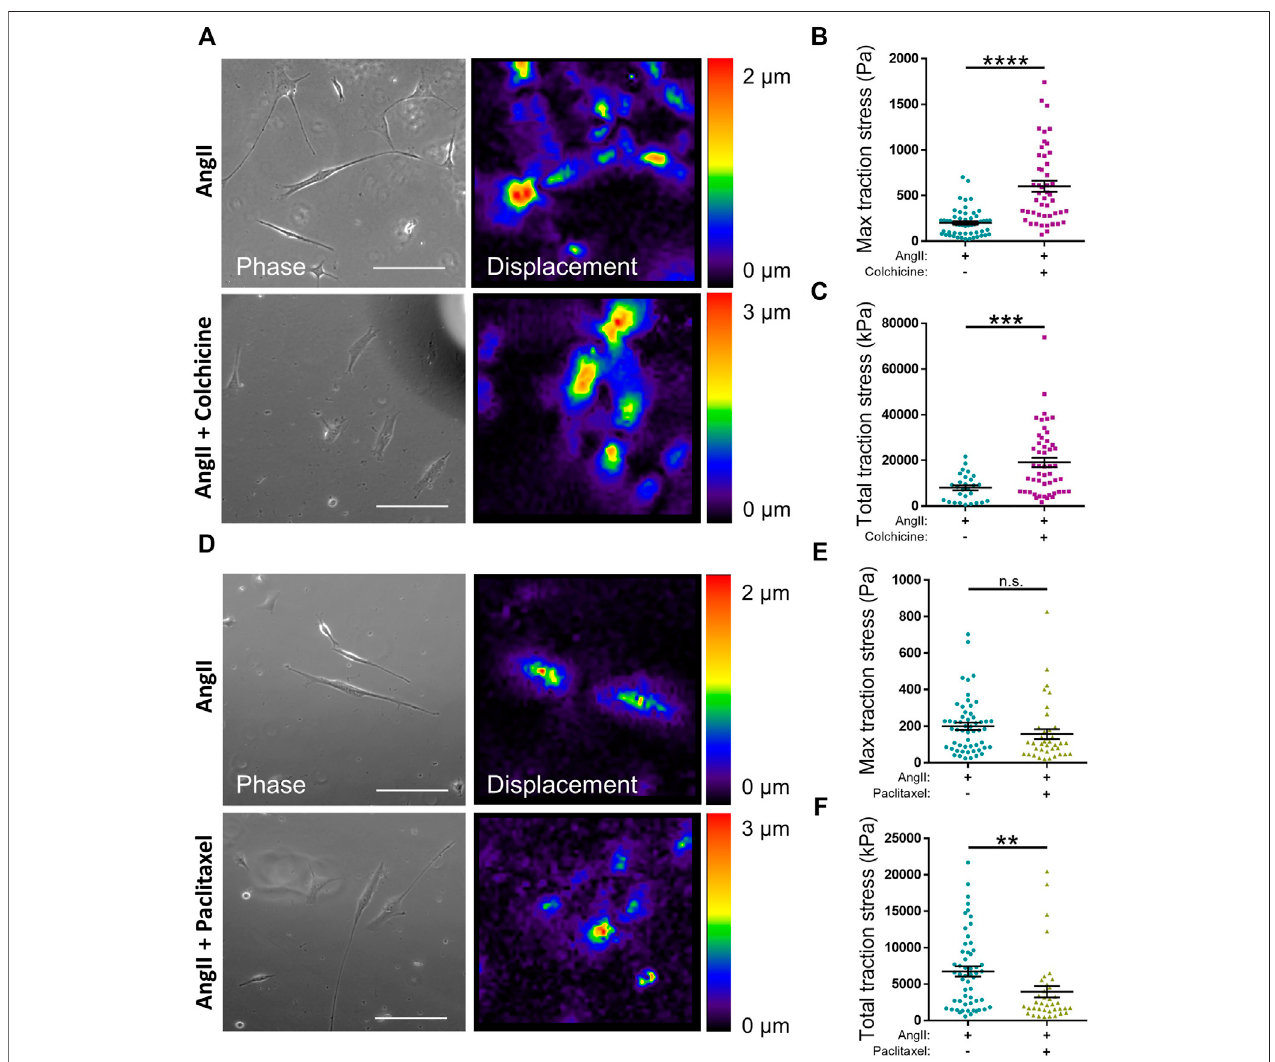
FIGURE 6 | Microtubule stability regulates angiotensin II induced VSMC traction stress generation. (A) Representative phase images and bead displacement heat maps of isolated VSMCs grown on 12 kPa polyacrylamide hydrogels. Cells were pre-treated +/ − colchicine (100 nM) for 30 min prior to cotreatment with angiotensin II (AngII) (10 µM) for an additional 30 min. Scale bar = 100 μ m. (B) Maximum traction stress and (C) Total traction stress generation. Both (B,C) are representative of 3 independent experiments with ≥ 48 cell analysed per condition. (D) Representative phase images and bead displacement heat maps of isolated VSMCs grown on 12 kPapolyacrylamide hydrogels.Cells were pre-treated +/ − paclitaxel (1 nM)for 30 min prior tocotreatment with angiotensinII(AngII) (10 µM) foran additional 30 min. Scale bar = 100 μ m. (E) Maximum traction stress generation and (F) Total traction stress generation. Both (E,F) are representative of 3 independent experiments